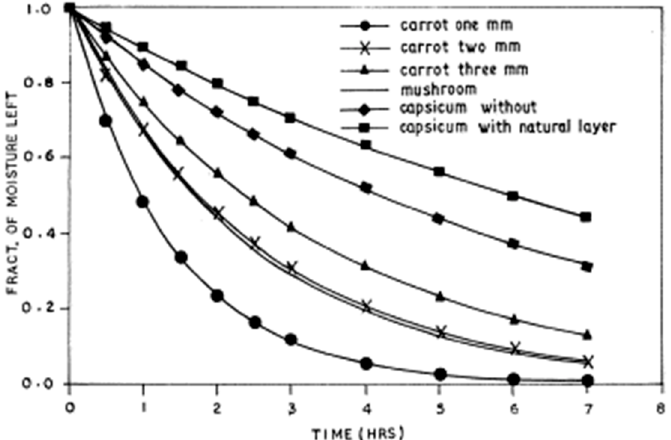
− Bt . Source: George